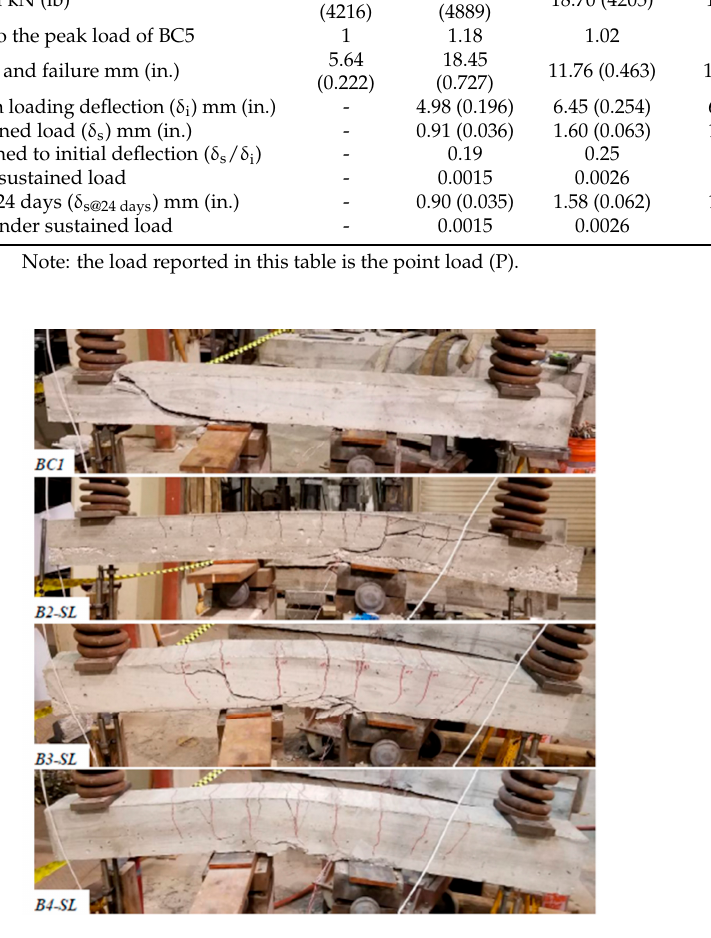
Figure 11. Beam series I failures.